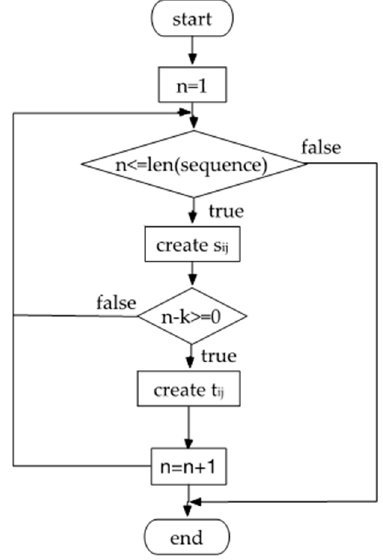
Figure 6. Process of extracting features.